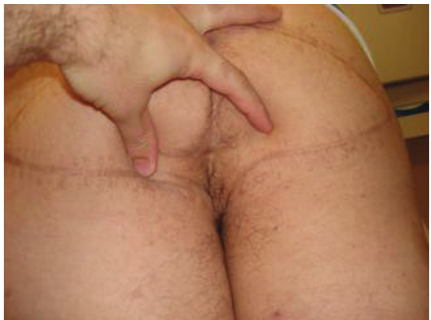
Figure 5: Final cosmetic outcome following abdominoperineal